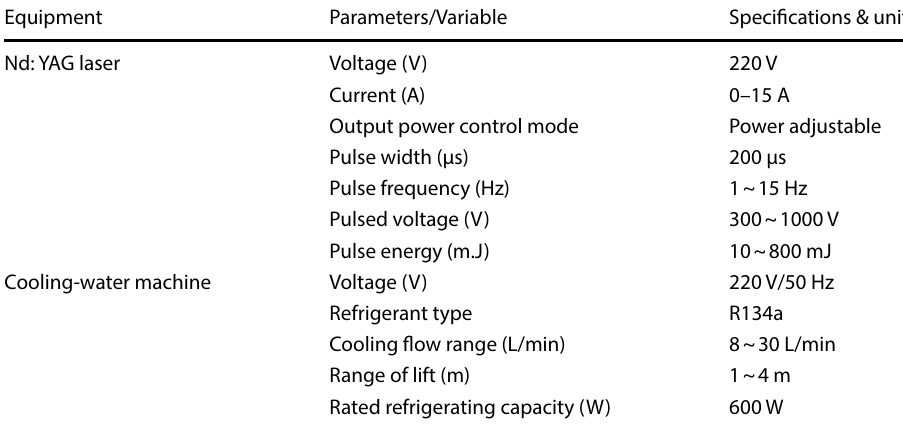
Table 3 Operating parameters of WJG Nd: YAG laser equipment